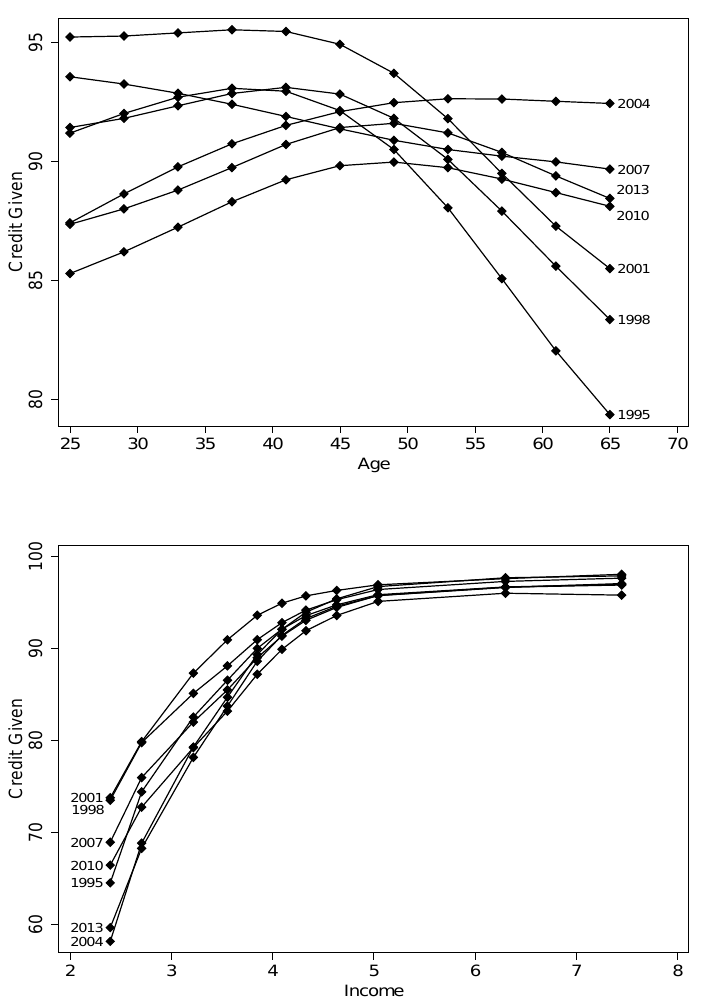
Figure 4. The Effect of Age and Income on Credit Acceptance Among Applicant Households. Note: These are kernel estimates of the percentage of households that wish to have credit actually receive credit as age/income changes holding the other variables fixed at their median value. The estimates of income are at every 10th centile of the income distribution (and additionally the 5th and 95th